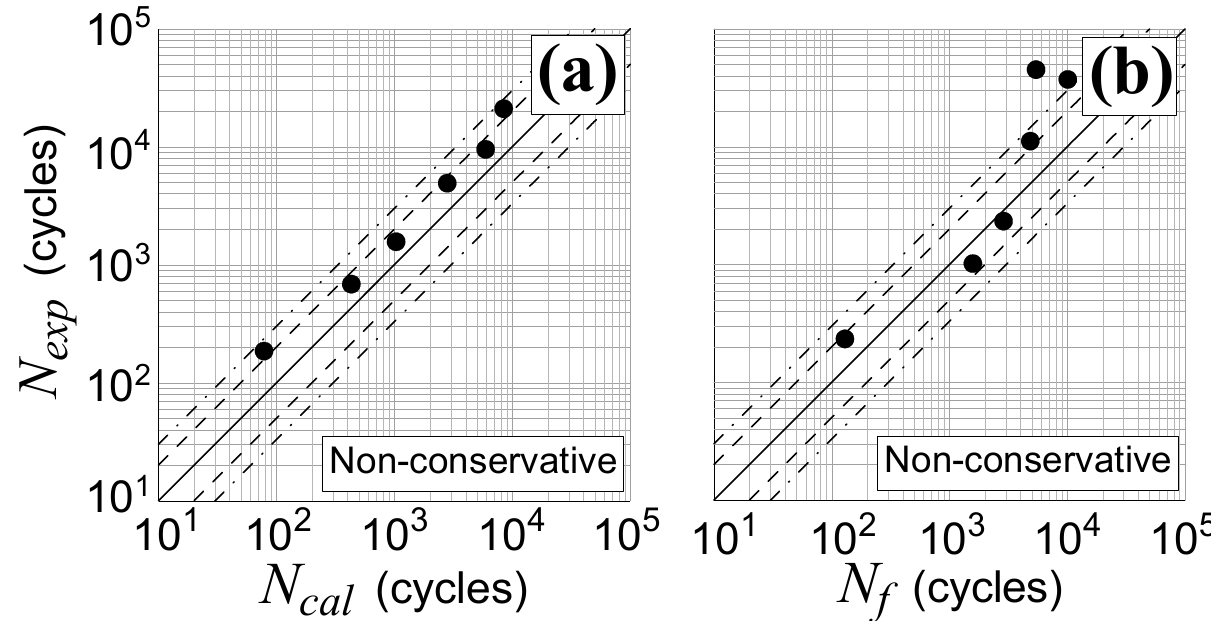
Figure 3. TC4 titanium alloy experimental and estimated lifetime obtained by the reduced strain range method for non-proportional tests with a phase shift, β , equal to: ( a ) 45 ◦ (Nos. T7–T12, in Table 2) and ( b ) 90 ◦ (Nos. T13–T18, in Table